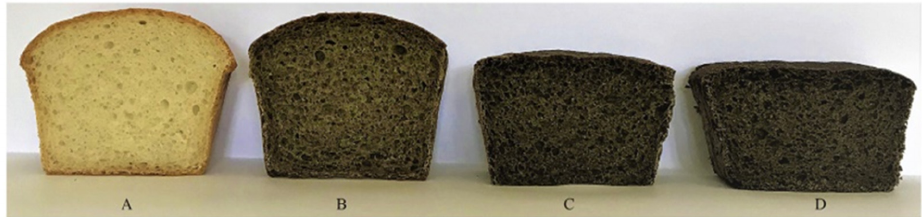
Figure 5. Transverse cuts of bread. Explanatory notes: ( A )—wheat bread, ( B )—bread with 15% hempseed flour, ( C )—bread with 30% hemp seed flour, ( D )—bread with 50% hemp seed flour (Reproduced with permission from Mikulec et al. (2019) [113] ). Table 5. Related researches on applications of hemp in food and feed.